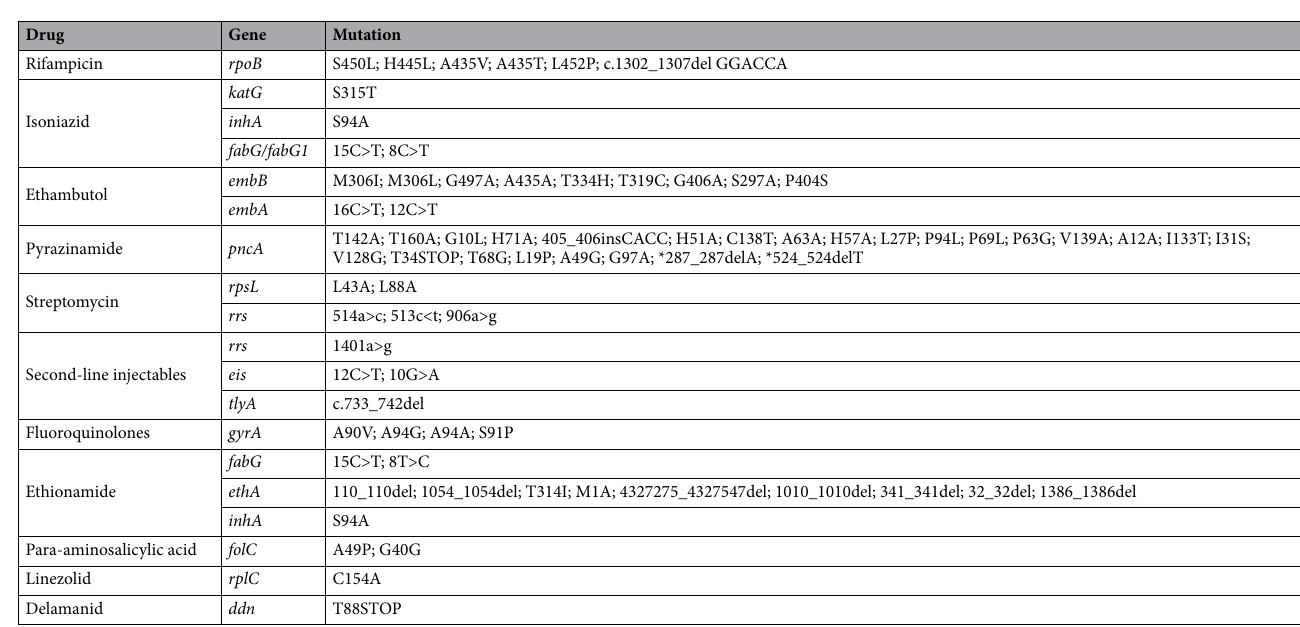
Table 2. List of mutations in the corresponding genes encoding resistance to first- and second-line antituberculosis drugs. *Novel mutation—not yet reported in the